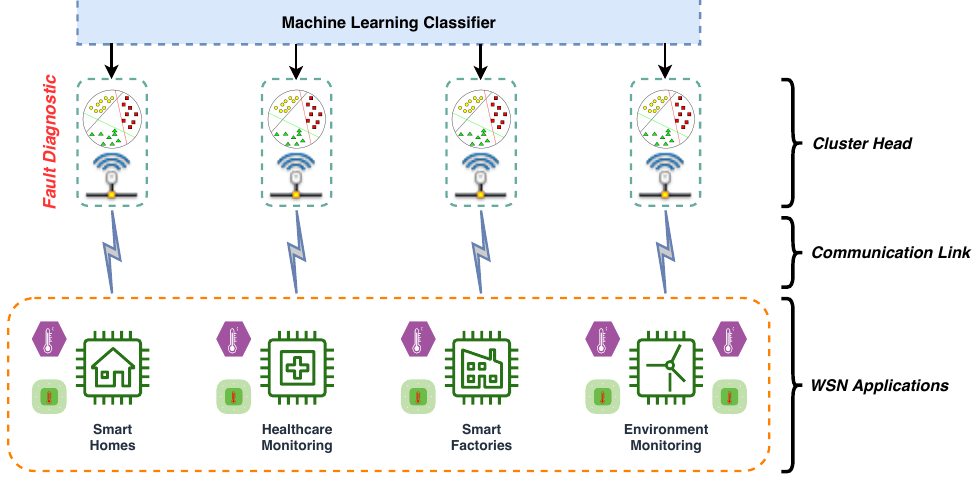
Figure 2. Architecture of the proposed fault diagnostic